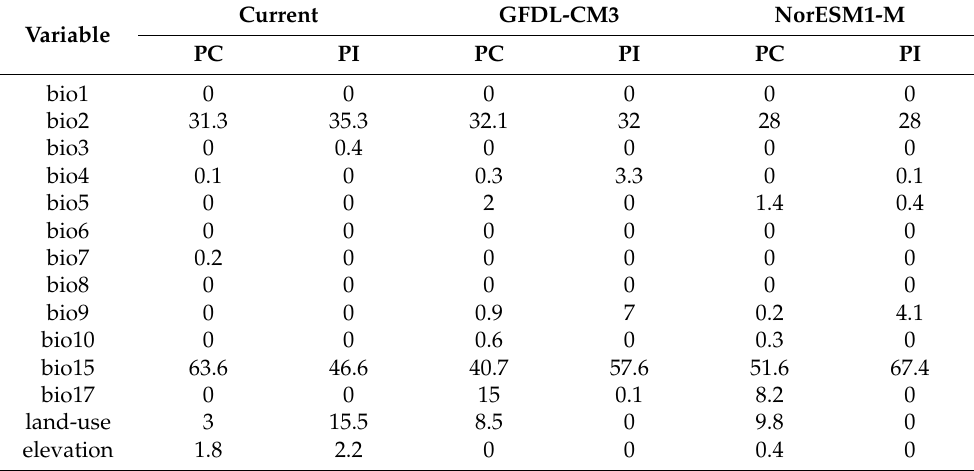
Table 4. Estimates of percent contribution (PC) and permutation importance (PI) of bioclimatic and environmental predictor variables of the MaxEnt habitat suitability modeling for the current and future (2050) distribution based on GFDL-CM3 and NorESM1-M of Kerivoula malpasi in Sri